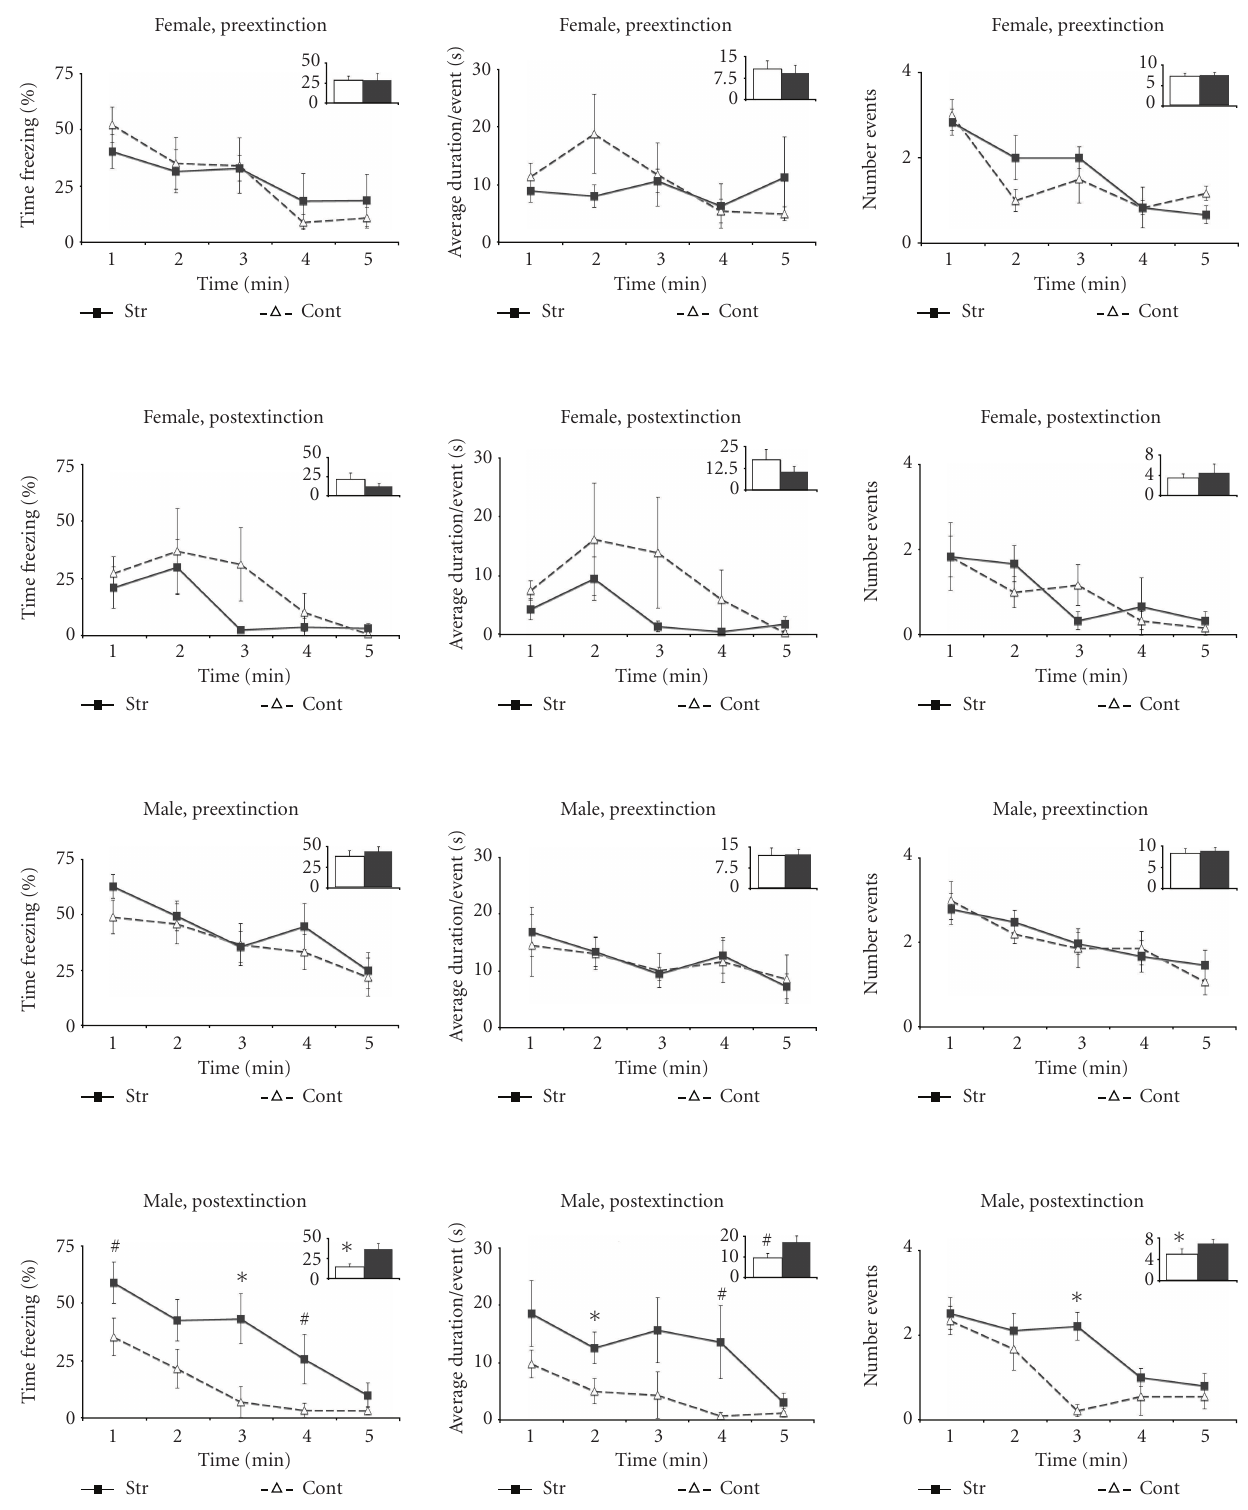
Figure 4: Auditory fear conditioning tests in adulthood before and after extinction. Mean percent freezing (left), duration of the average freezing event (middle), and number of freezing events (right) ( ± SEM) on successive 1minute blocks during reexposure to the conditioning tone in female (two upper panels) and male (two lower panels) rats that were submitted to stress prior to the onset of puberty (filled squares) or control animals (open triangles). Within each panel the upper row shows the values before extinction and the lower row shows the values after extinction. Within these figures, the total freezing value (percentage, average duration, or number) during the entire duration of the tone is represented as bars in the inserts. ∗ P < . 05, # P < . 05 < .